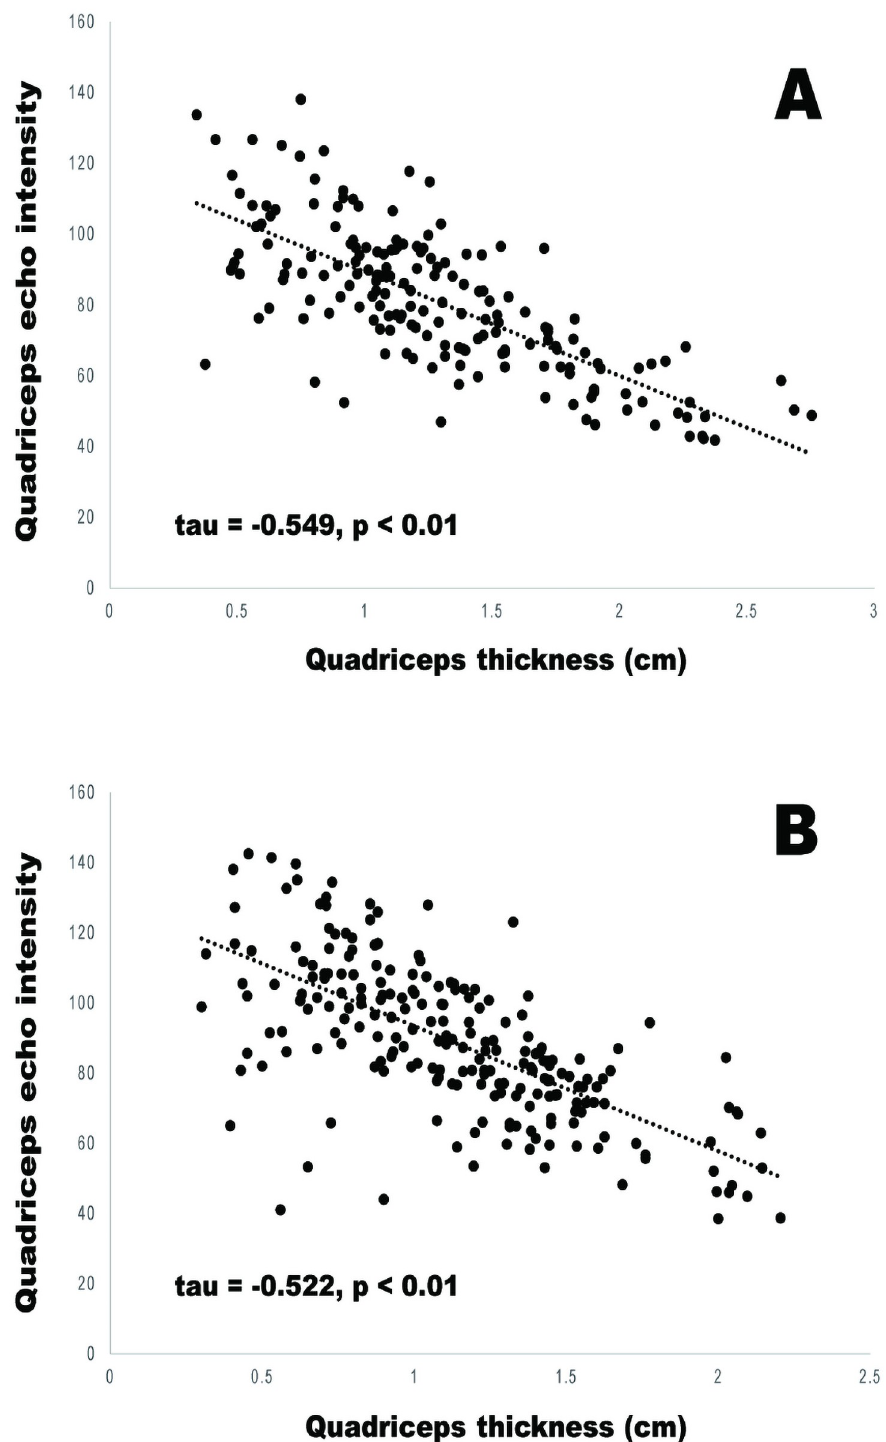
Fig 1. Association between muscle thickness and echo intensity of the quadriceps in male (A) and female (B) inpatients.